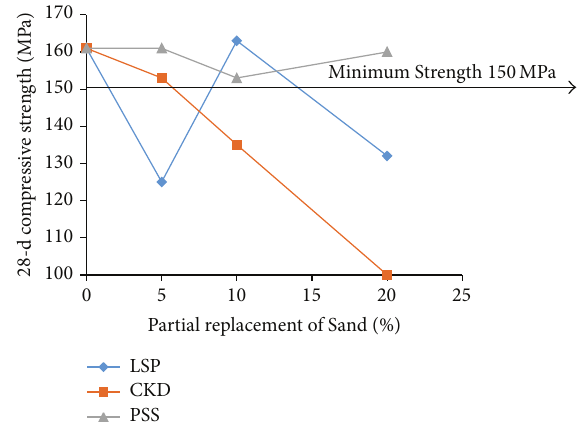
Figure 8: Variation of compressive strength with replacement of sand by LSP, CKD, and PSS.